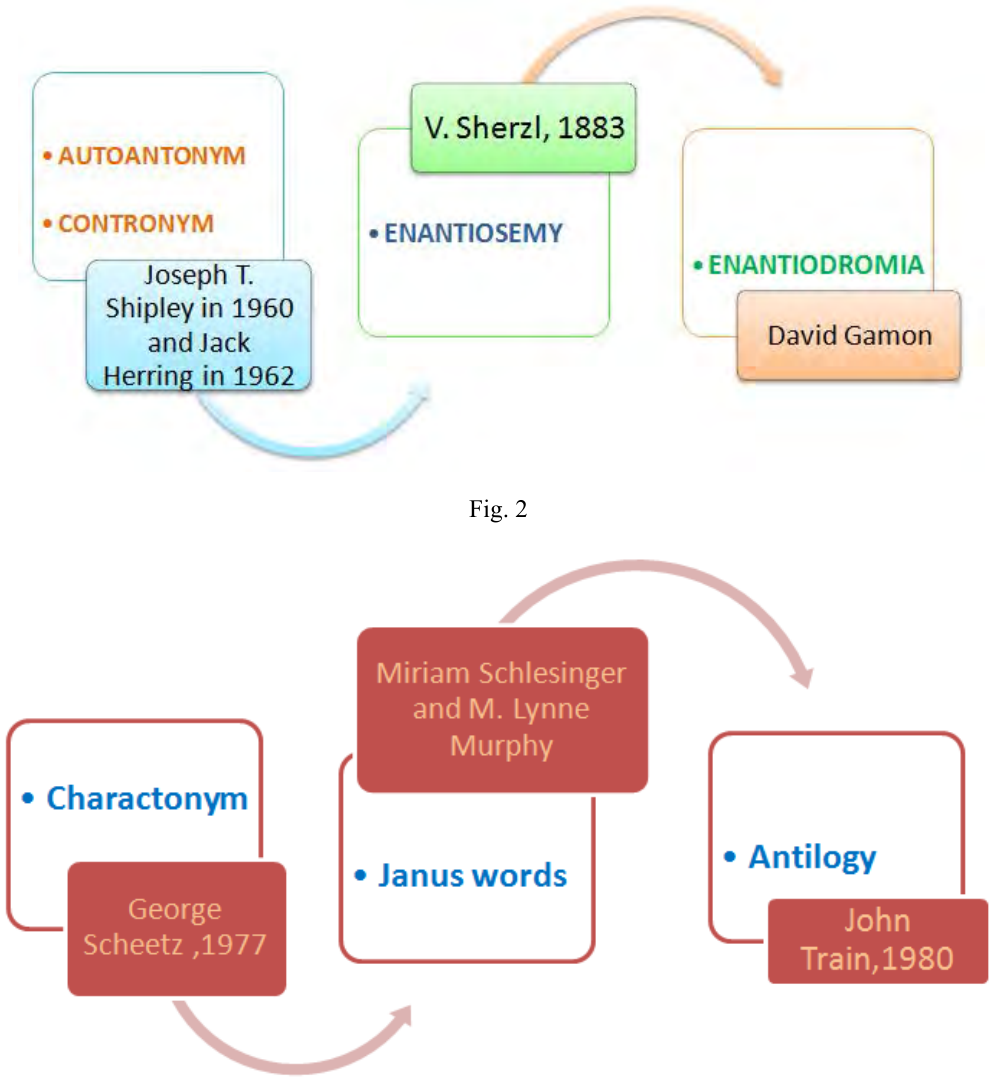
Fig. 3 – Concepts for the “enantiosemy” phenomenon given throughout history by different linguists (Fig.